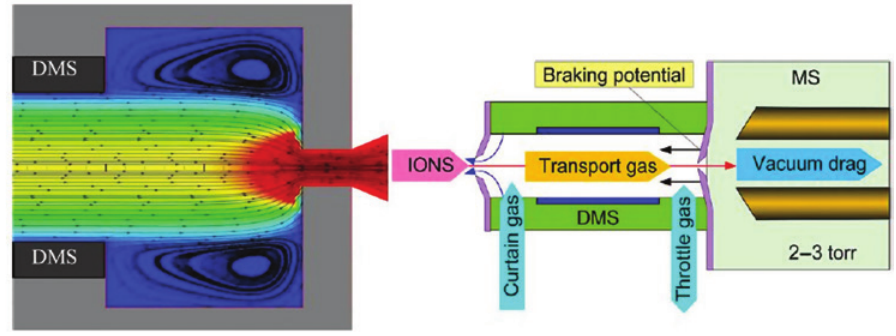
Figure 4: Simulation of optimization of DMS-MS